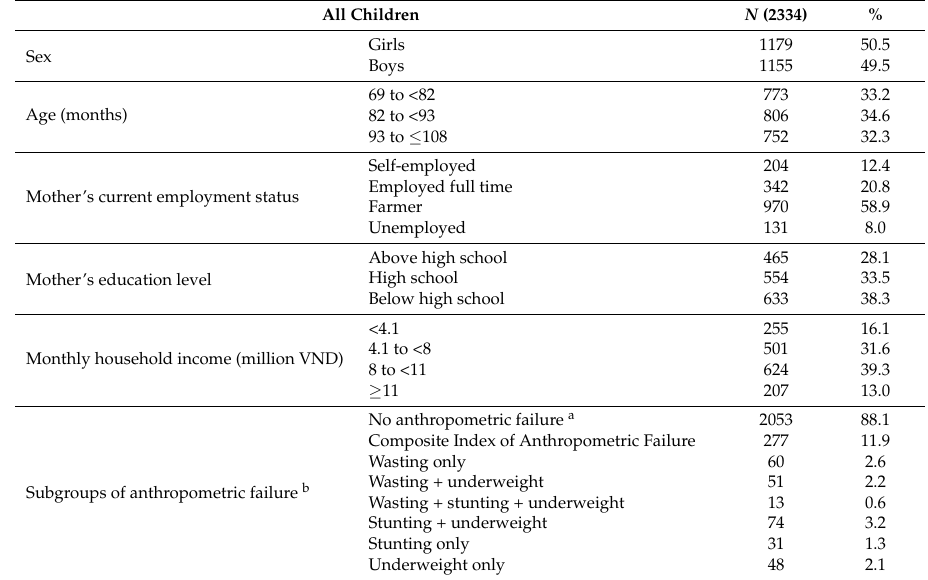
Table 1. Characteristics of the study participants.